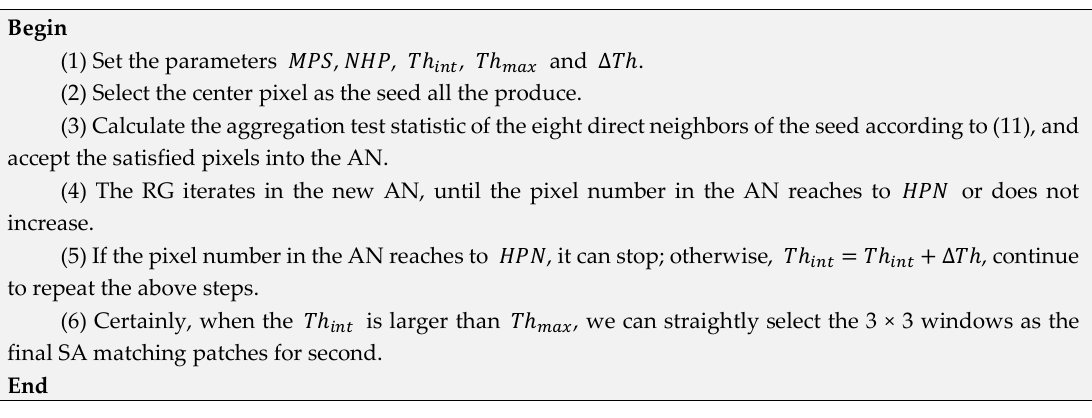
Figure 2. Flowchart of the proposed PolLRT-CMRG method for constructing SA matching patches.